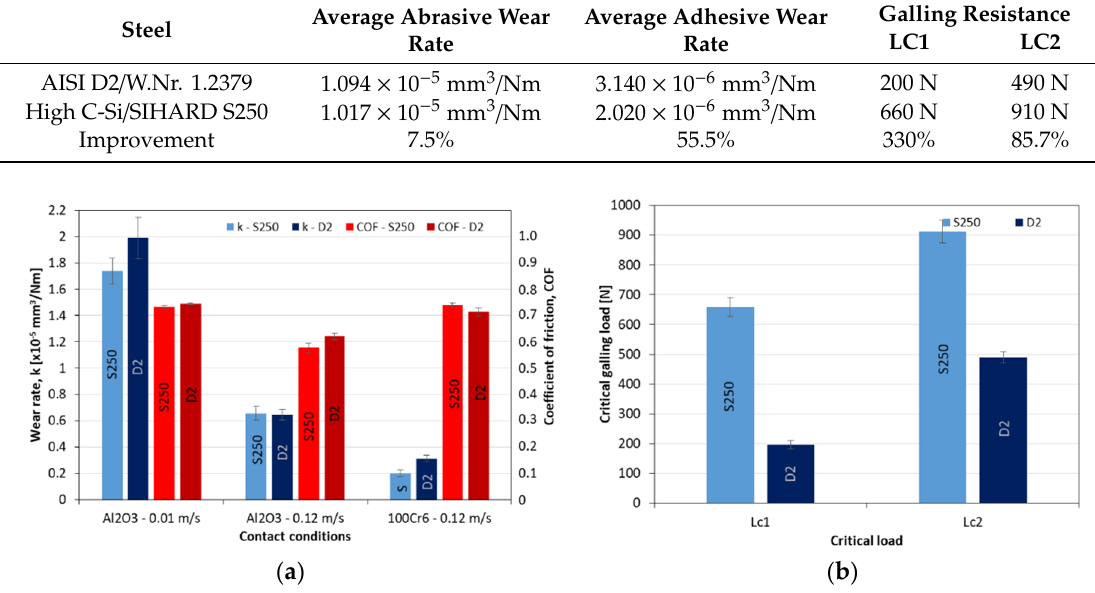
Figure 8. Tribological test results: ( a ) wear rate and average coefficient of friction for abrasive and adhesive wear testing, ( b ) critical loads in galling test .